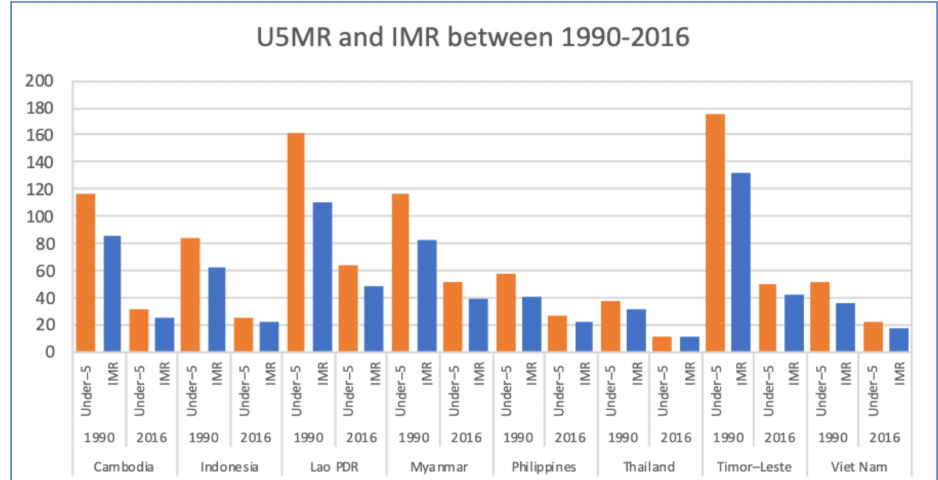
Figure 2. Under-5 mortality and infant mortality rate in 1990 and 2016 of selected countries in the South East Asia region. Data source: Levels and trends in child mortality 2019, UNICEF, WHO, World Bank Group and United Nations [11].